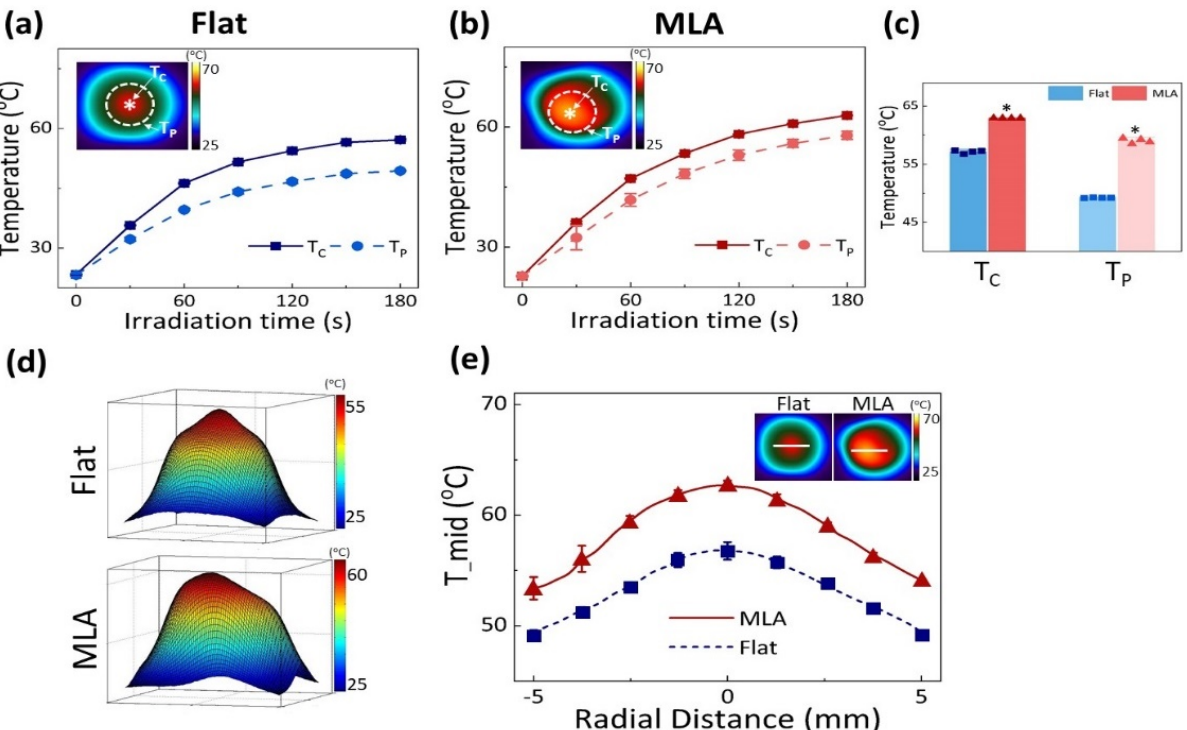
Figure 3. Comparison of photothermal effects between Flat-based and MLA-assisted irradiations at 2 W/cm 2 for 180 s on IR 1601 aqueous solution (300 µ g/mL in PBS): temporal developments of surface temperature at central (T C ; measured at r = 0 mm; white asterisk) and peripheral (T P ; measured at r = 4 mm; white dashed line) regions obtained from ( a ) Flat and ( b ) MLA, ( c ) comparison of elevated temperatures at T C and T P , ( d ) 3D images of temperature fields after irradiation (360 J/cm 2 ), and ( e ) comparison of radial temperature distributions along middle line (T _mid ) of IR images. Note that the inlets in ( a ), ( b ), and ( e ) represent the captured IR images after 180 s irradiation ( n = 4; * MU p < 0.005 vs. Flat).